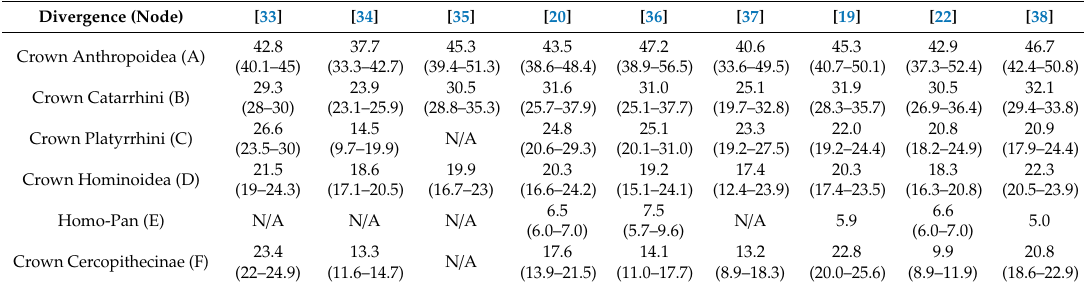
Table 2. Fossil dates used as calibration points of divergence time estimates in this study that have undergone extensive review in previous publications and are supported by a consensus of